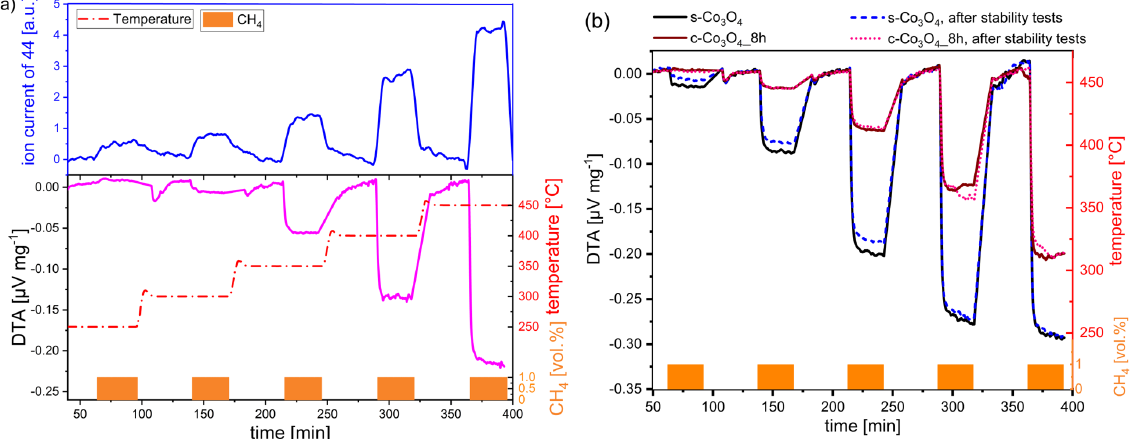
Figure 4. (a) DTA curve in comparison to MS curve of ground Co 3 O 4 (8h) under exposure to CH 4 . (b) DTA curves for two different Co 3 O 4 catalysts before and after thermal stability investigations. Conditions – pulses of 1vol% CH 4 in dry air for 30min in a temperature range between 250 and 450 ◦